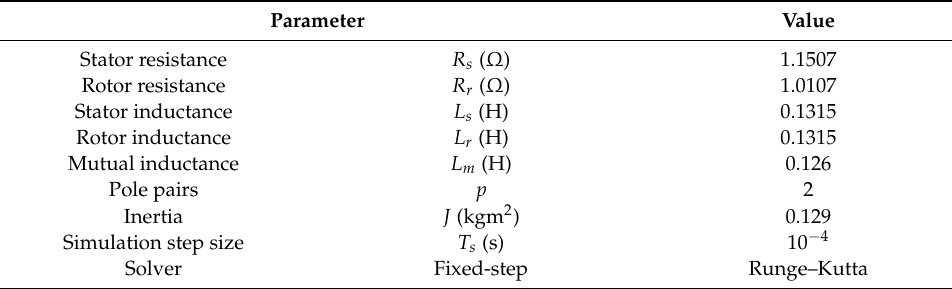
Table A1. Induction machine and simulation